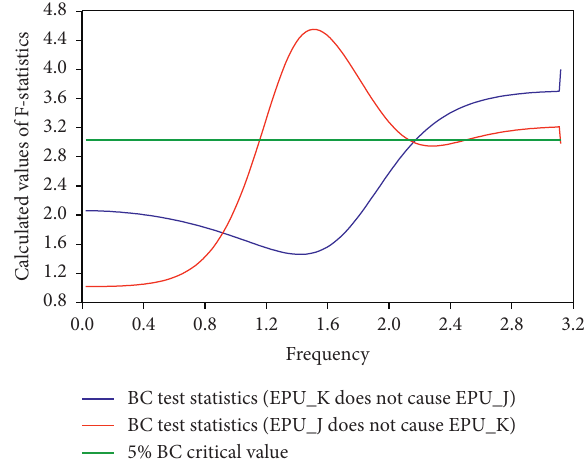
Figure 7: The frequency domain causality between Korea’s and Japan’s EPU indices. The part of the lines above the critical value- line indicates rejection of the null hypothesis of no Granger